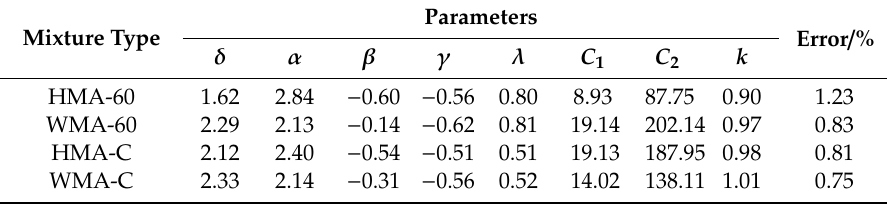
Table 4. GSM fitting parameters for dynamic modulus and phase angle.